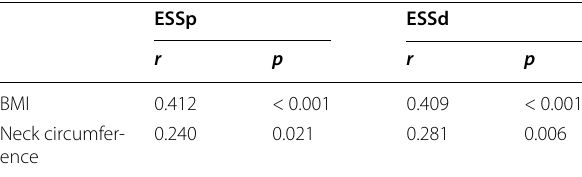
Table 3 Correlations of ESSp and ESSd with BMI (kg/m 2 )